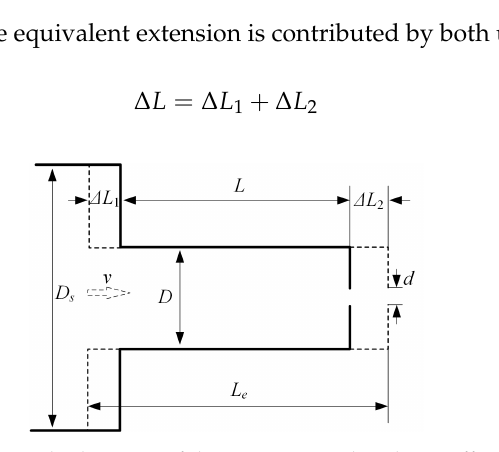
Figure 9. Conceptual schematic of the organ-pipe chamber’s effective length.